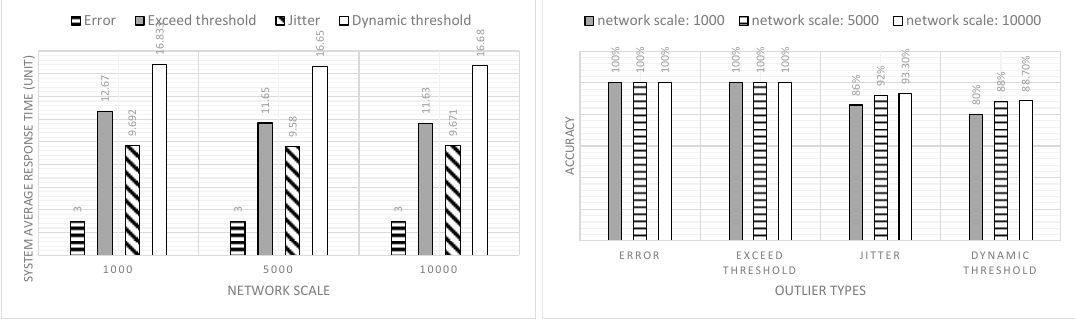
Figure 6. The comparison of the system average response time and accuracy under different network scales and fixed sampling rate (sampling rate = 1 / 10 sec ).